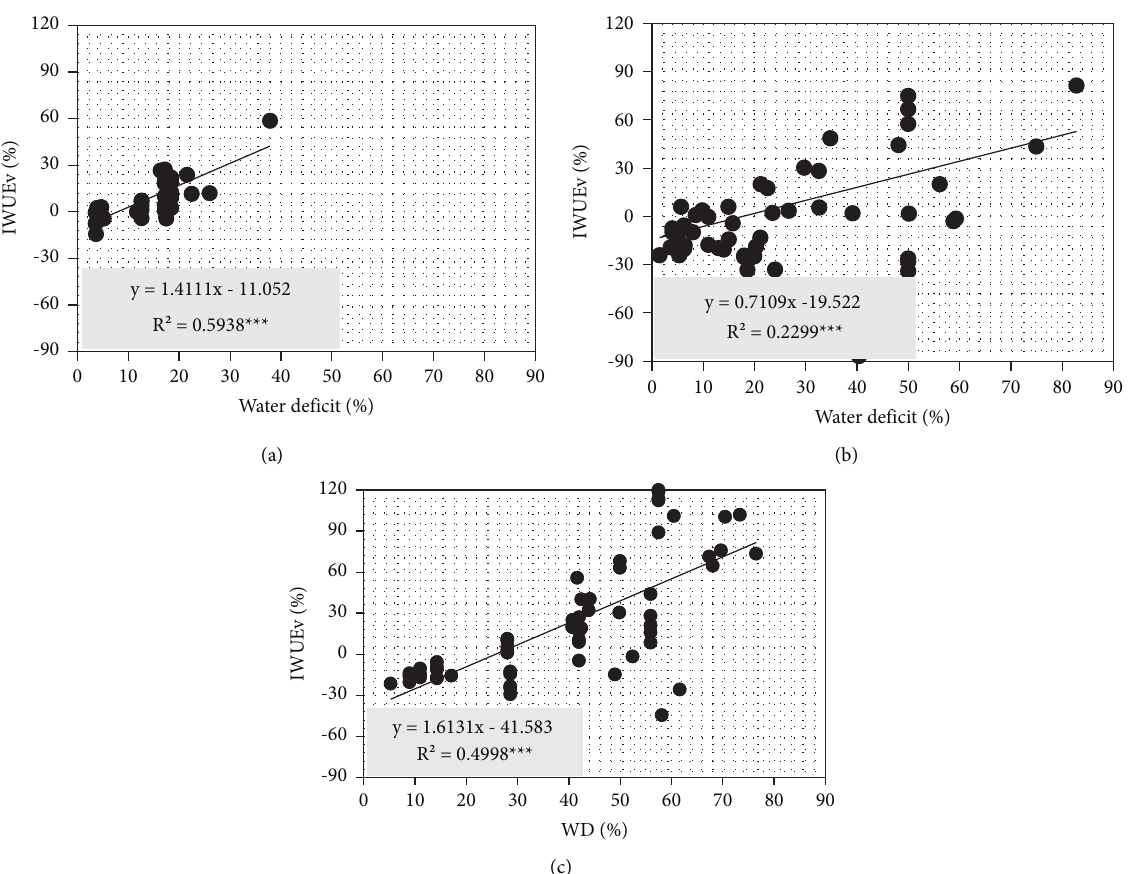
Figure 8: Trend of IWUE V under defcit irrigation set at (a) vegetative stage, (b) reproductive stage, and (c) at vegetative and reproductive stages; ∗∗∗ p <